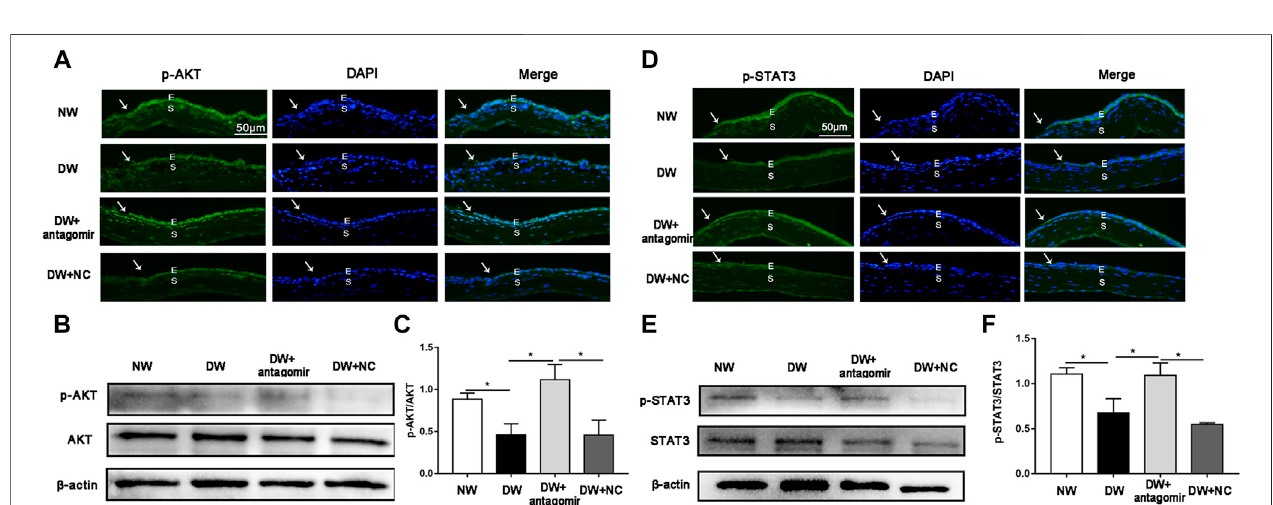
FIGURE 8 | miR-223-5p antagomir improved the phosphorylation of AKT and STAT3. (A) Immuno fl uorescence corneal staining showing the p-AKT protein expression in normal mice (NW group), diabetic mice (DW group), and diabetic mice subconjunctivally injected with miR-223-5p antagomir (DW + antagomir group) or antagomir NC (DW + NC group) 24 h post-injury. (B,C) Western blotting assay measured the p-AKT protein levels of the cornea 24 h post-injury in each group. (D) Immuno fl uorescence corneal staining and (E,F) western blotting assay showing p-STAT3 protein expression in the same four groups 24 h post-wounding. (C,F) Data were analyzed by one-way ANOVA. If signi fi cant, multiple comparations were then performed. * p -value of < 0.05.